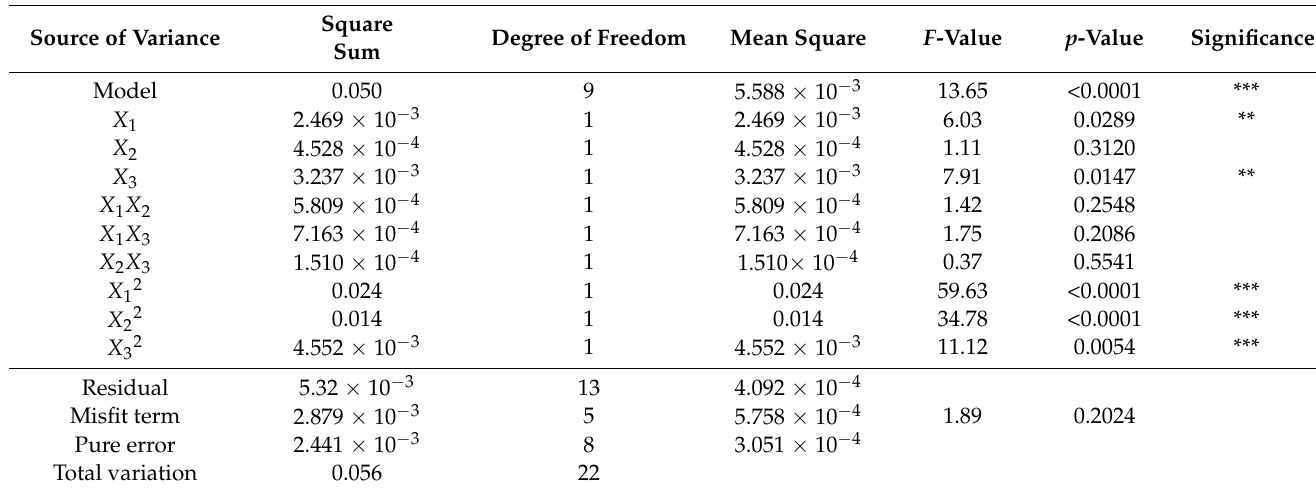
Table 6. Analysis of variance of average velocity of fertilizer